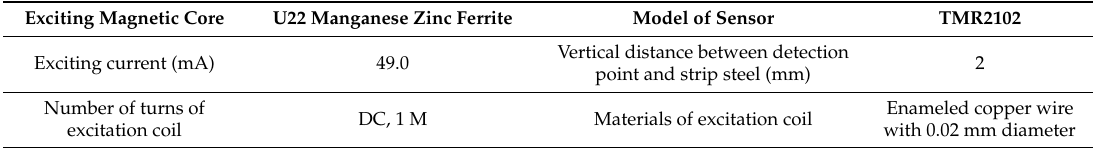
Table 4. Exciting system and sensor parameter in experimental process.